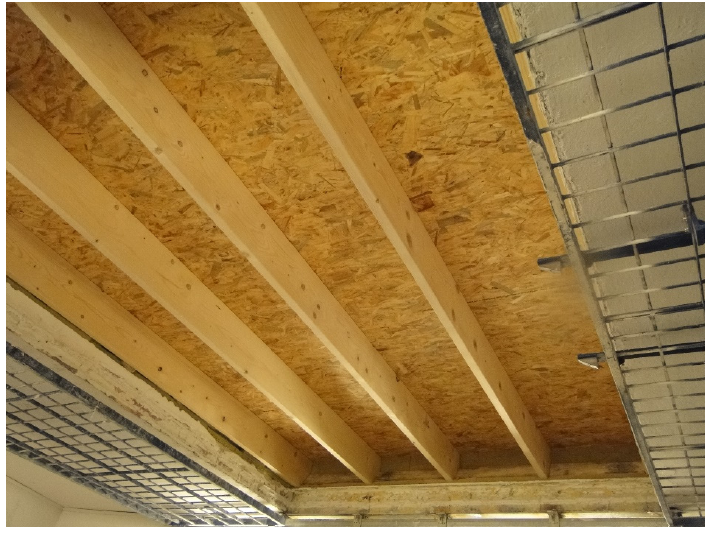
Figure 4. Basic construction of the wooden floor (model 1a) in a test facility. Table 2. Specification of the wood frame floors (models 1e–f).